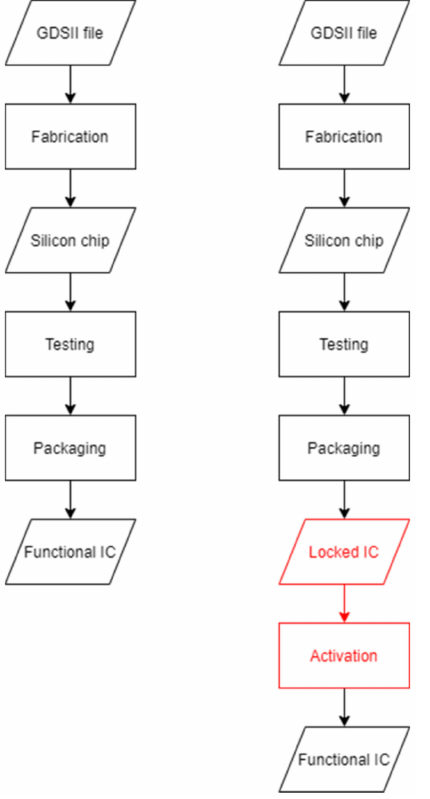
Figure 12. IC fabrication and activation